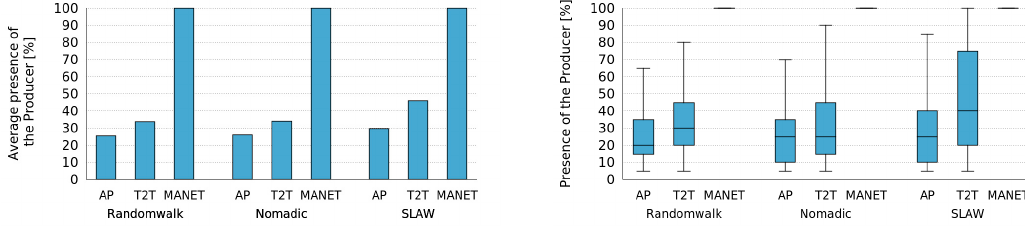
Figure 10. Presence of the Producer for different mobility patterns when no Control Tier is available.